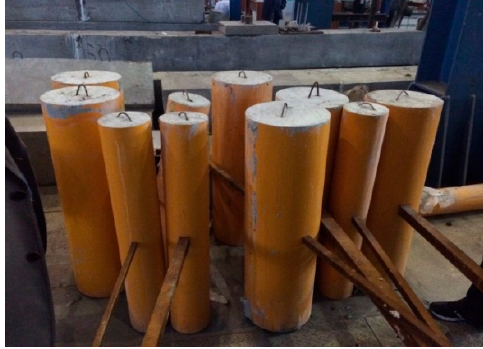
Figure 2. Specimens after preparation.